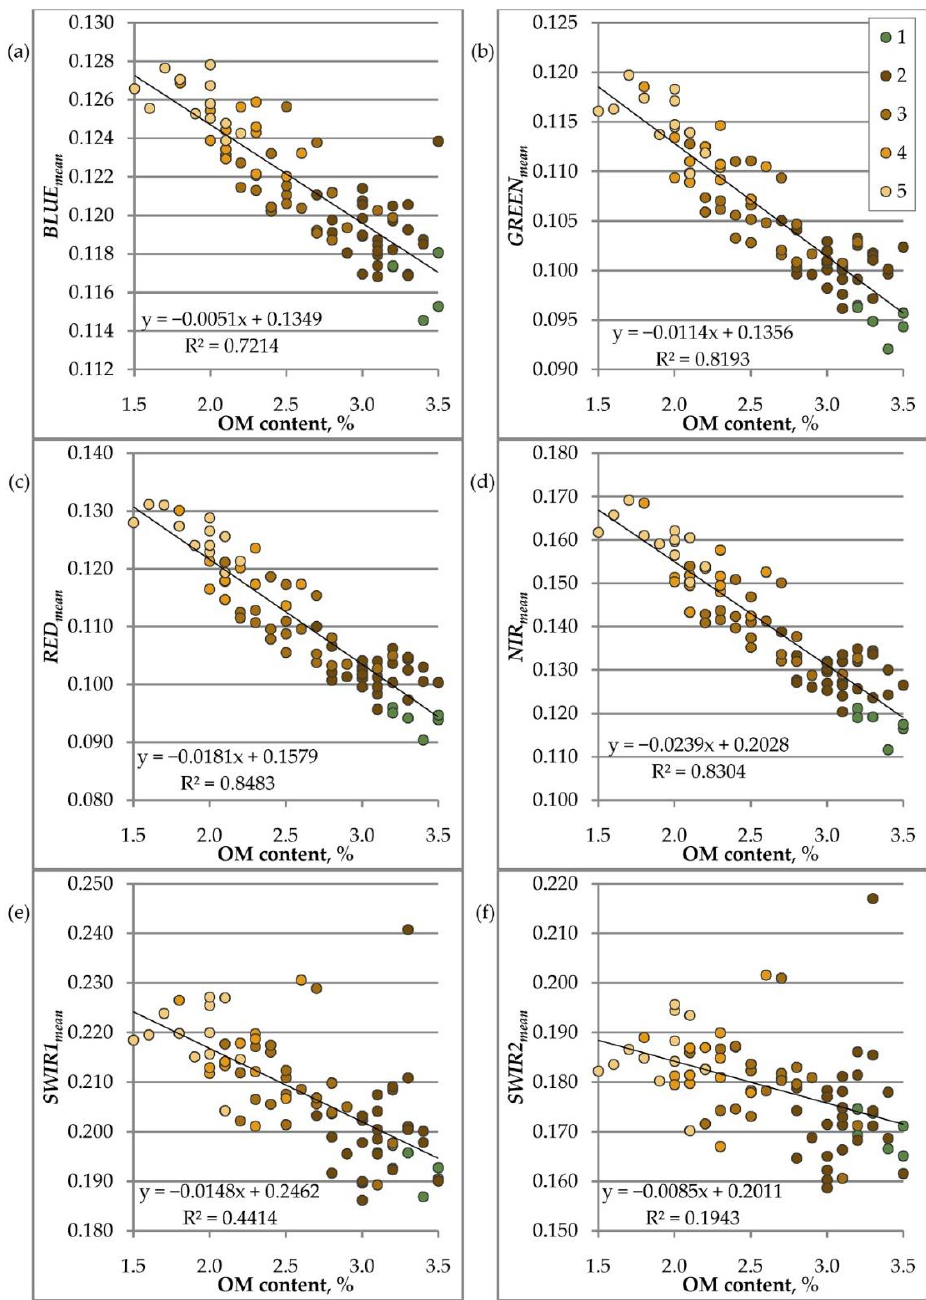
Figure 6. Correlation of BAND mean values and the OM content (soils are: 1 — meadow-chestnut, 2 — dark chestnut, 3 — dark chestnut slightly eroded, 4 — dark chestnut medium eroded, 5 — dark chestnut strongly eroded).